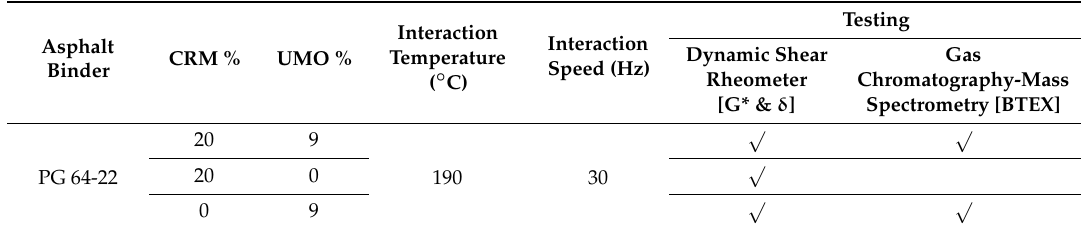
Table 1. Interaction matrix and the implemented testing